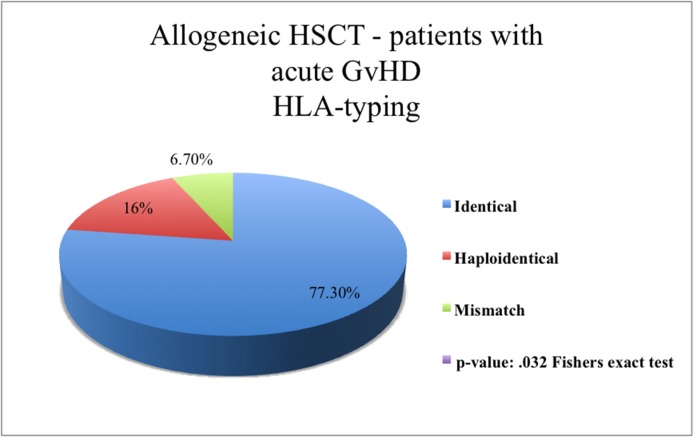
Patients after allogeneic HSCT with acute GvHD.Stated the HLA-typing of transferred stem cells. The distribution of HLA-typing across all patients in the allogeneic patient group occurred acute GvHD is displayed as a pie chart. Statistical significant difference p = .002FE.